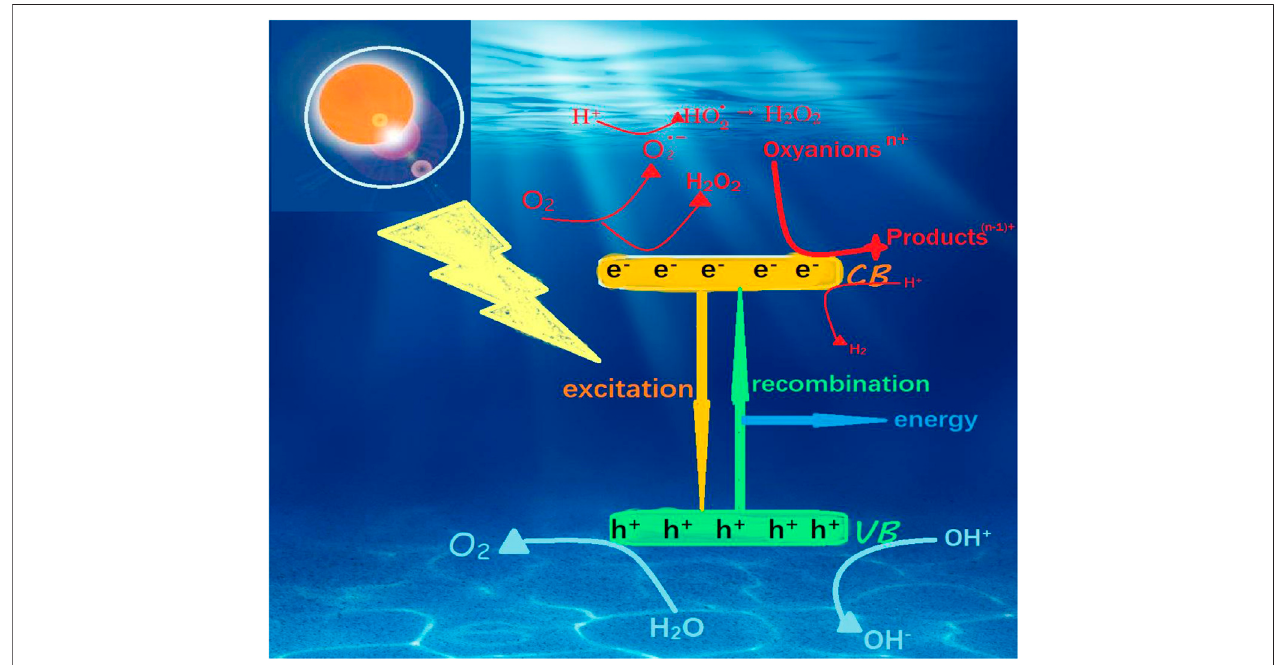
FIGURE 5 | Structure diagram of tetracycline